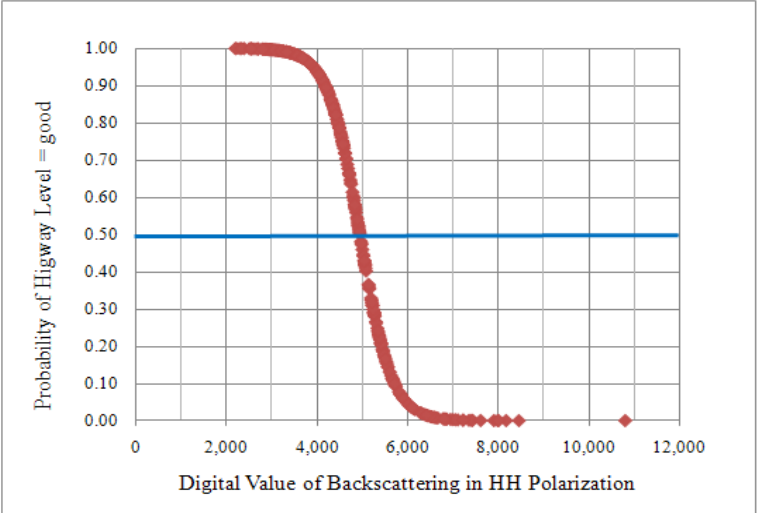
Figure 6. Relationship between backscattering and probability of selection of highway service level = good.